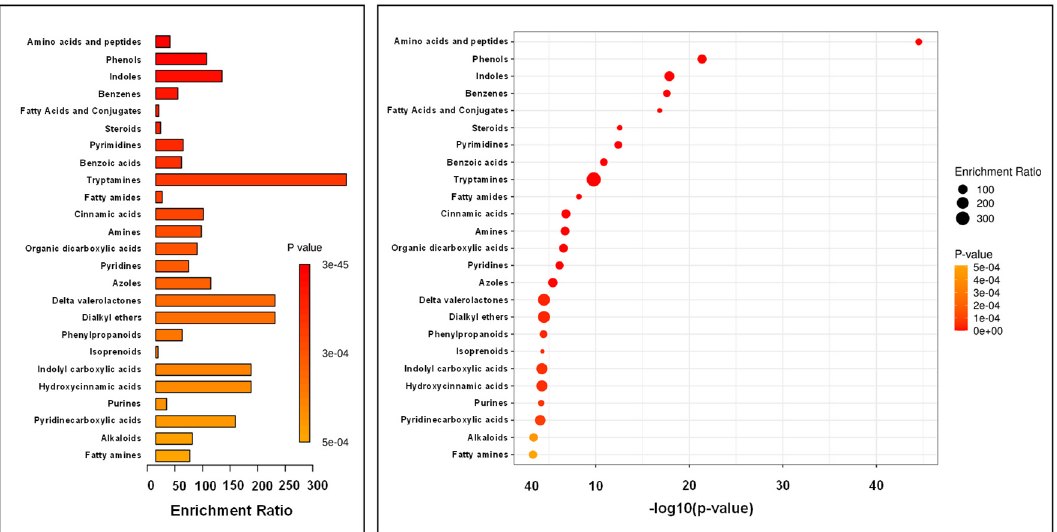
Figure 15. Summary of pathway enrichment analysis of leachate samples based on main class compound analysis. The most significant p -values are in red, while the least significant are in orange. The Enrichment Ratio is computed by Hits/Expected, where hits = observed hits; expected = expected